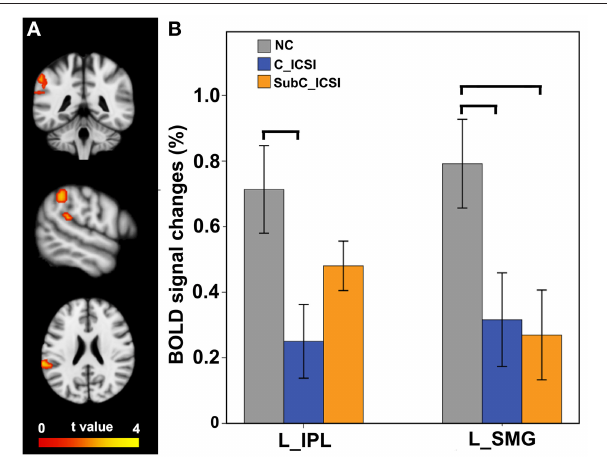
FIGURE 6 | Intergroup activation differences between the ISCI subjects and the NC subjects in the MI task. Compared to the NC subjects, the ISCI subjects showed decreased activation in the left SMG and IPL (uncorrected, P < 0.05 and cluster ≥ 30 , A ). Furthermore, the activation decrement in the left IPL of the cervical ICSI subgroup was not significant compared to that of the NC subgroup, while that in the left SMG in both the cervical and sub-cervical ISCI sub-groups was comparable (B) . ISCI, incomplete spinal cord injury; NC, normal controls; MI, motor imagery; SMG, supra marginal gyrus; IPL, inferior parietal lobule. The horizontal bar represents a statistically significant difference between the two groups.